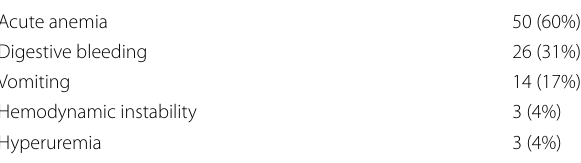
One patient could have various reasons for performing the upper gastrointestinal endoscopy. Data are presented in n (%)